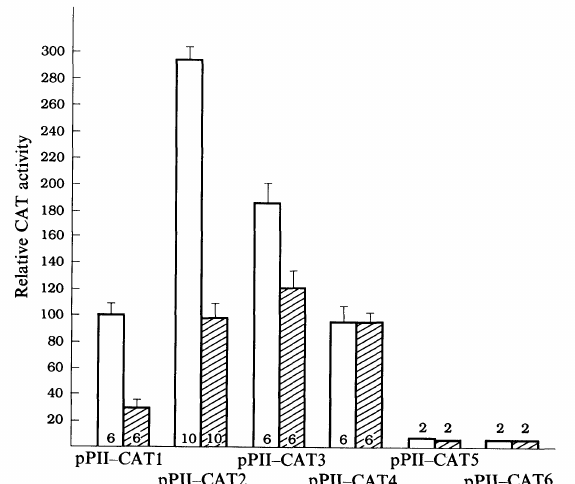
FIG. 2. Relative transcription rates of 5’ deletion mutants of acetyl CoA carboxylase promoter II. Various carboxylase promoter I/CAT constructs as shown in Fig. 1A were transfected into subconfluent 30A5 cells followed by a 60 h incubation in the absence or presence of TNF. The CAT activity obtained from pPII-CAT1 which was included in each experiment was set as 100%. The number of plates used to obtain data for each bar is indicated. Error bars indicate the range of three determinations. The size of PII in each construct is: pPII-CAT1, -674/+62; pPII-CAT2, -434/+62; pPII-CAT3, -340/+62; pPII- CAT4, -285/+62; pPII-CAT5, -135/+62; pPII-CAT6, -35/+62. I--I, Control; I